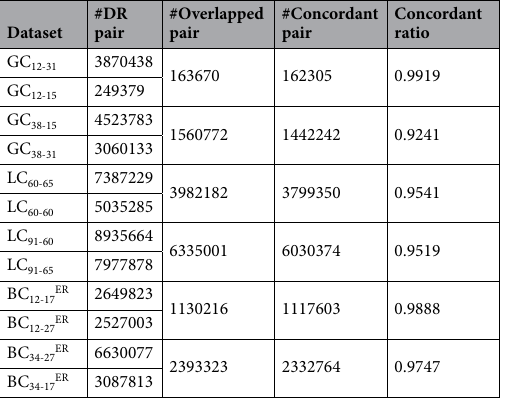
Table 4. Concordance of DR gene pairs identified from datasets with the same case samples but different control samples.